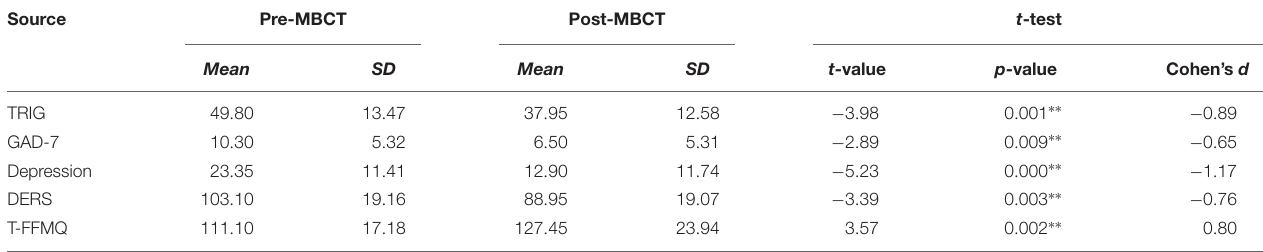
TABLE 1 | Descriptive and statistical overview of self-reported questionnaires between pre- and post-MBCT on grief bereavement (means and standard deviations). Source